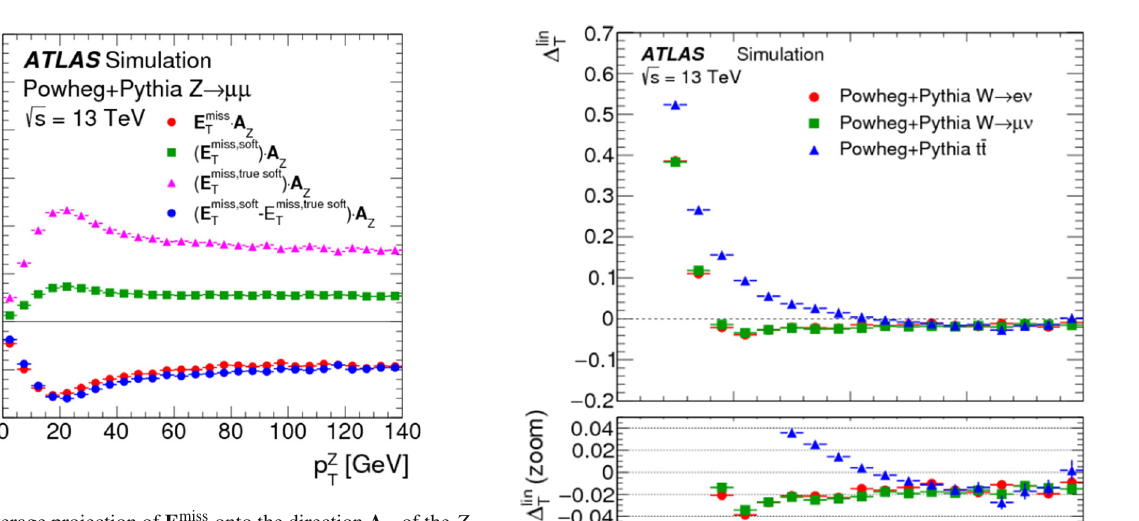
Fig. 5 The average projection of E miss onto the direction A Z of the Z T boson’s transverse momentum vector p Z , as given in Eq. (10), is shown T = | p Z | in Z → μμ events from the inclusive MC as a function of p Z T T sample. The average projection of the soft term and the true soft term Fig. 6 The deviation of the E miss response from linearity, measured are also shown, to demonstrate the source of the deviation from zero T as a function of the expected E miss , true by (cid:9) lin in Eq. (11), in W → e ν , T T W → μν , and t ¯ t final states in MC simulations. The lower plot shows , true a zoomed-in view on the (cid:9) lin dependence on E miss , true with a highly portional to E miss , with the reconstructed recoil being T T T suppressed ordinate approximately 2% too small. The W → e ν and W → μν ( E miss , true ) , thus indicating final states show very similar (cid:9) lin T T the universality of the recoil reconstruction and the indepen- In t ¯ t final-state reconstruction, resolution effects tend , true (cid:2) 120 GeV. Compared to in a dence on the lepton flavour of the reconstructed E miss at E miss to dominate (cid:9) lin T T T , true > 0. low-multiplicity final state with E miss the W → e ν and W → μν final states, a T